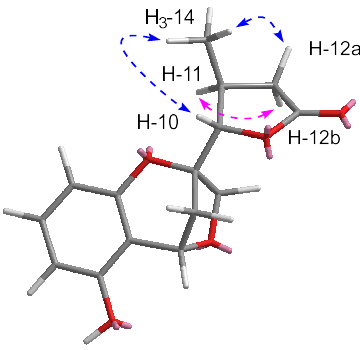
Figure 3. Key rotating overhauser effect (ROE) correlations of compound 1 .